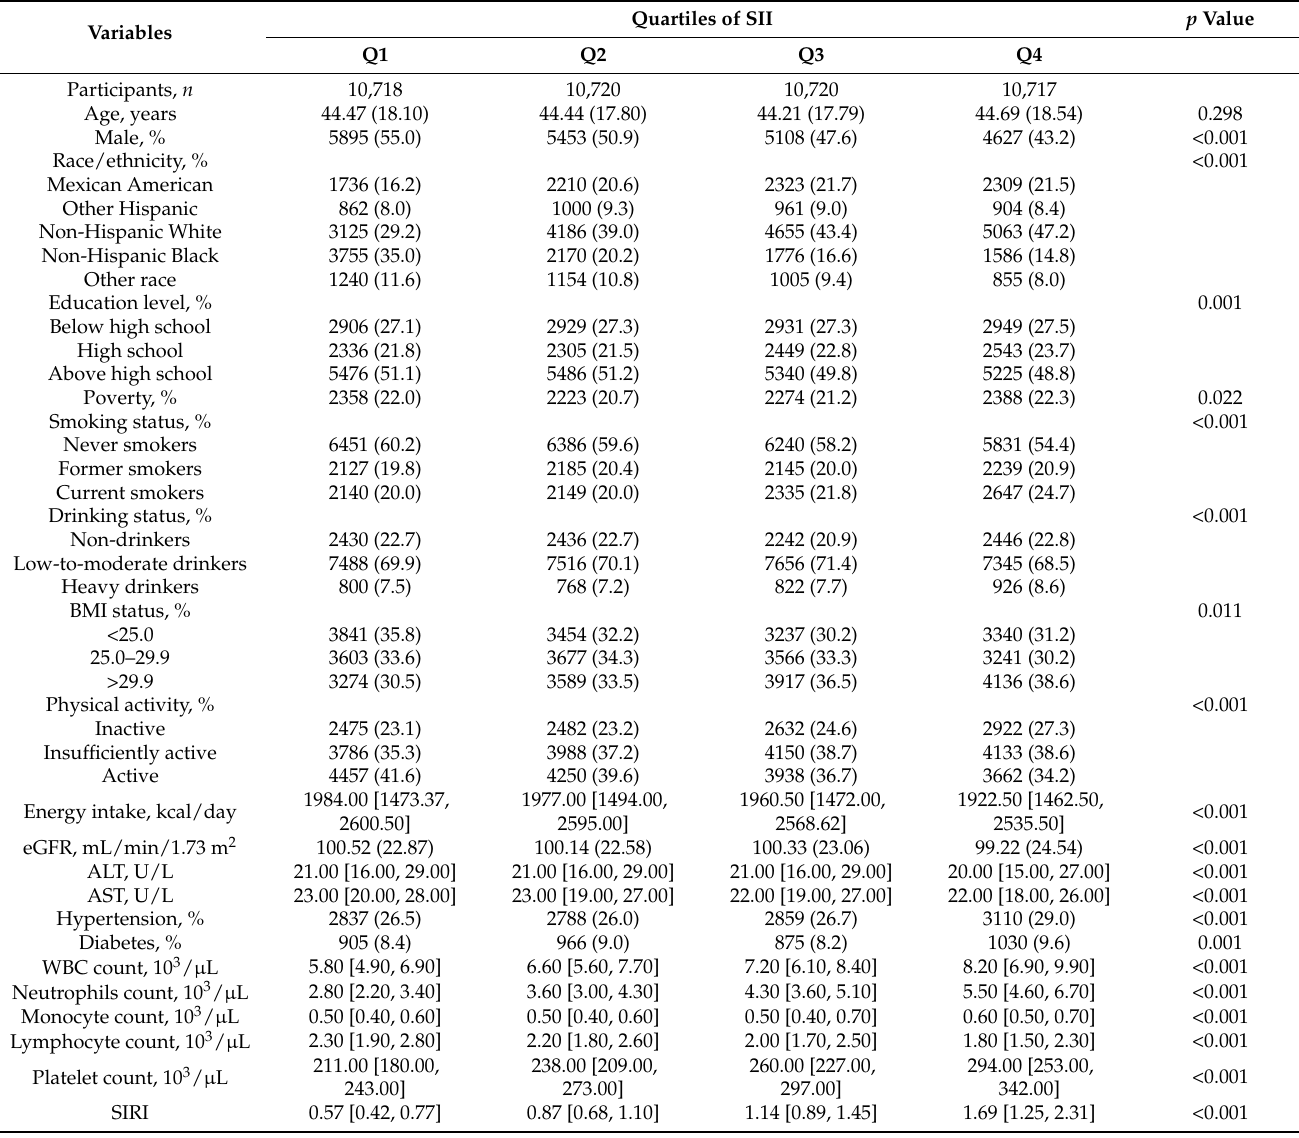
Table 1. Baseline characteristics of quantiles of Systemic immune inflammation index (SII) among the general adult population in the National Health and Nutrition Examination Survey (NHANES),